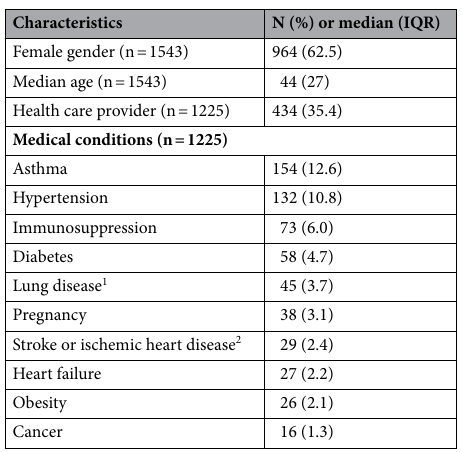
Table 1. Sociodemographic characteristics and medical conditions of 1543 patients included in the study. 1 Number of available data: 1224. 2 Number of available data: 1223.